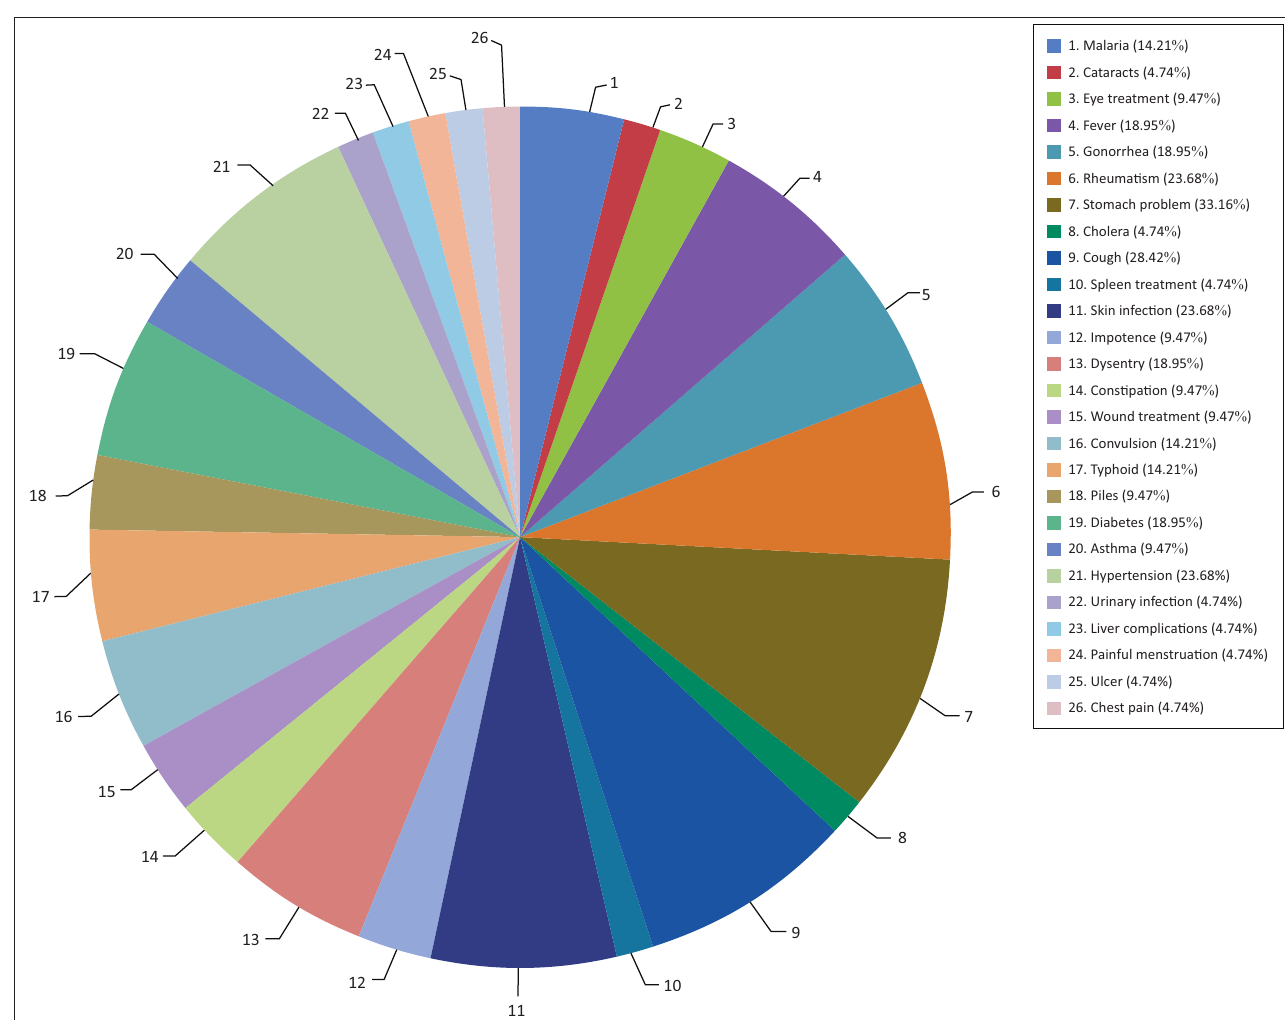
FIGURE 4: The major ailments treated with plant species in Otuo, Owan East Local Government